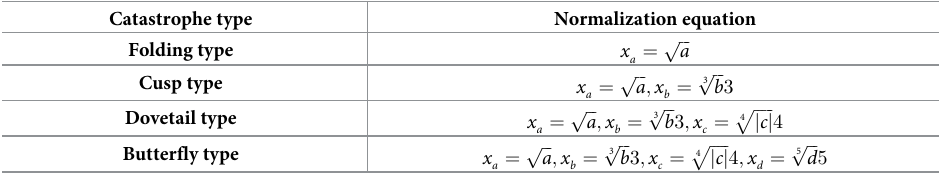
Table 3. Normalization equation of catastrophe series model.